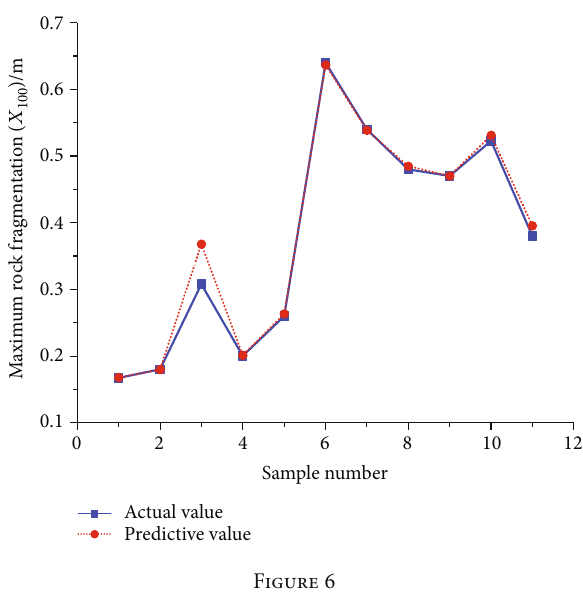
Table 5: Performance indicators of the of two algorithms. Algorithm